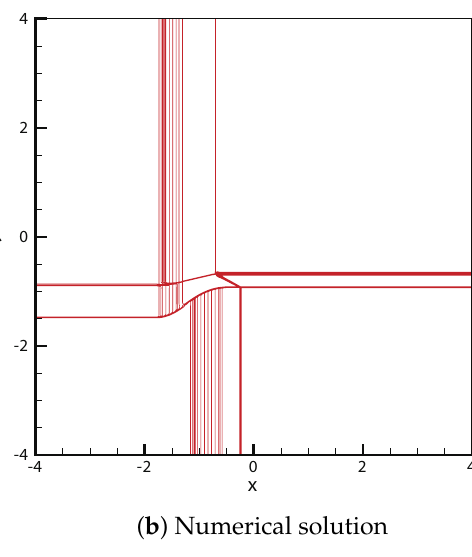
Figure 11. Case 9. JR + JS + RJ +